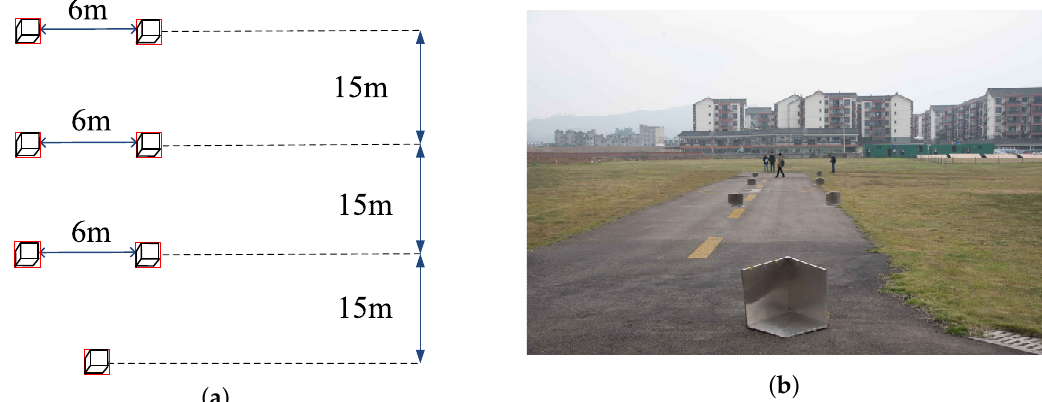
Figure 10. Experiment scenario ( a ) the diagram of the relative positions of the corner reflectors; ( b ) optical scenario. Table 3. Experiment